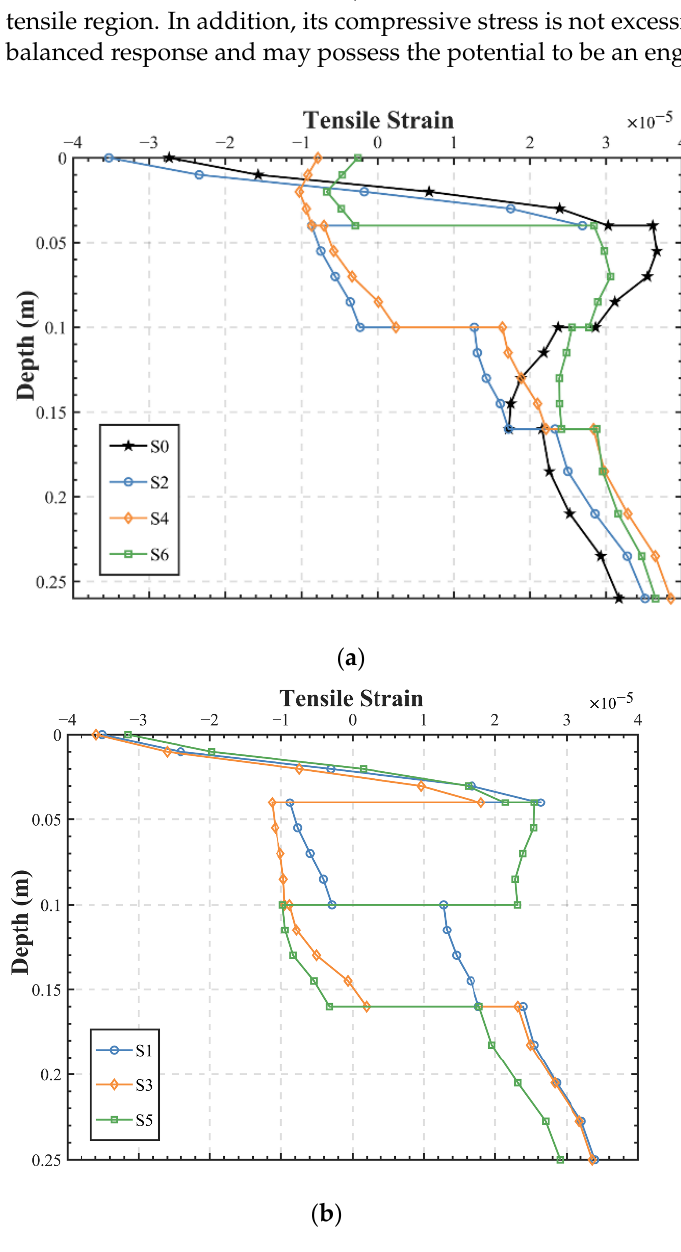
Figure 7. Pavement strain along depth: ( a ) S0, S2, S4, and S6; ( b ) S1, S3, and S5.